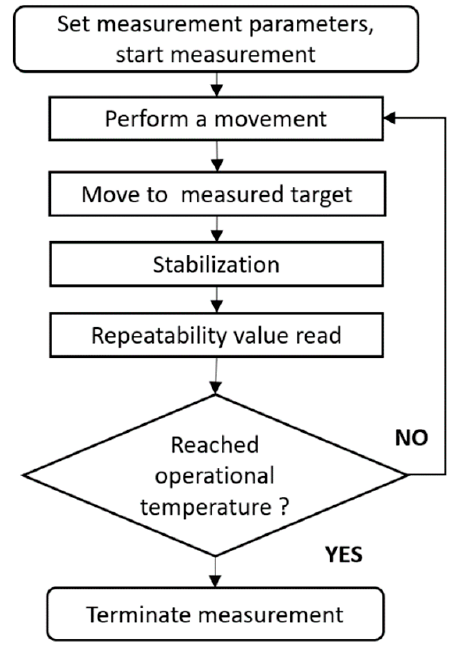
Figure 5. Flowchart of the control system for the experimental measurements.